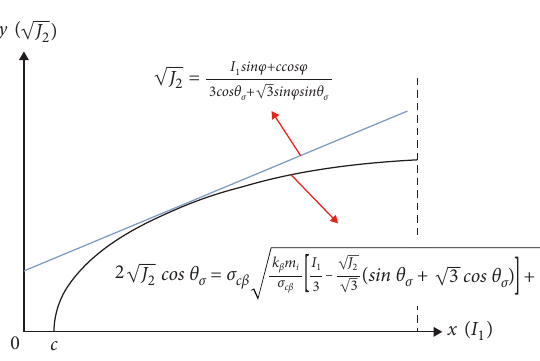
Figure 1: Instantaneous equivalence